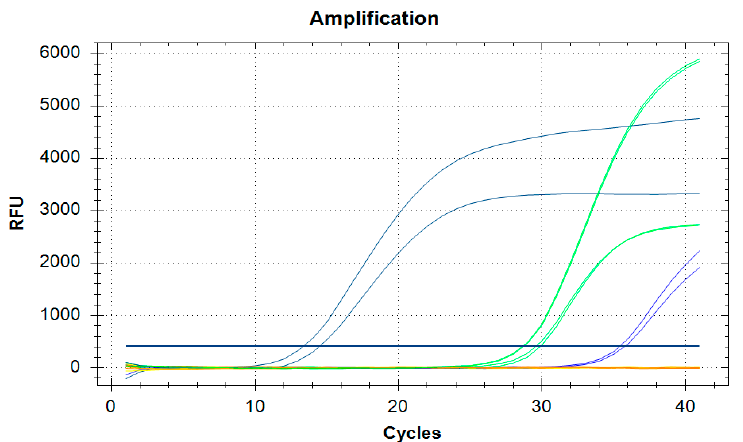
Figure 6. Amplification of a sample of a honeybee colony investigated for CBPV and ABPV in duplicate, result: ABPV = Ct 35.23, CBPV = Ct 14.33; green = positive controls, blue = CBPV, violet = ABPV, where the sample lines cross the blue straight line, Ct is determined, © Julia Dittes.